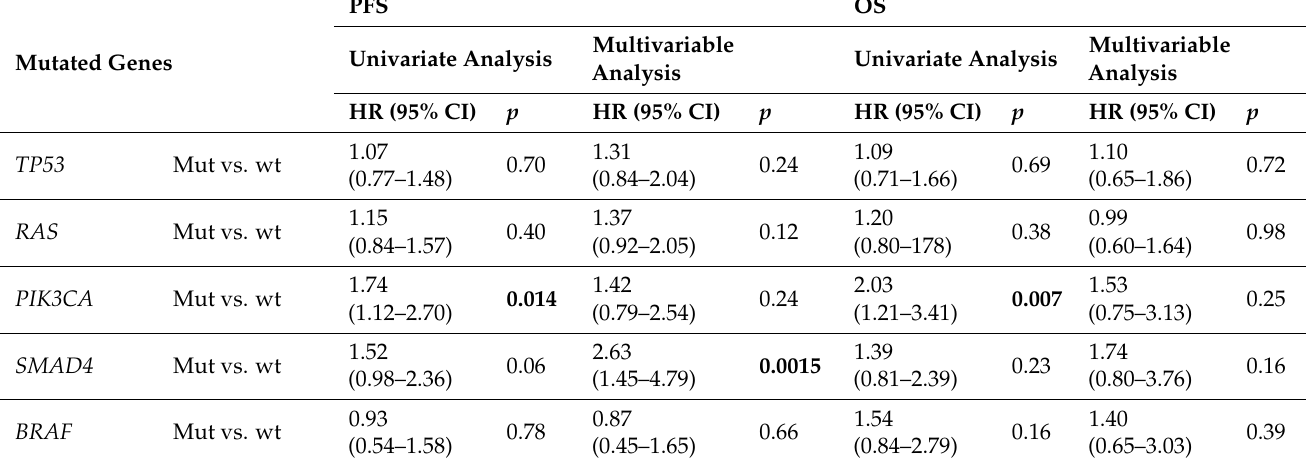
Table 3. Cox models for PFS/OS stratifying by the annotated mutated genes (individually or in com- bination).